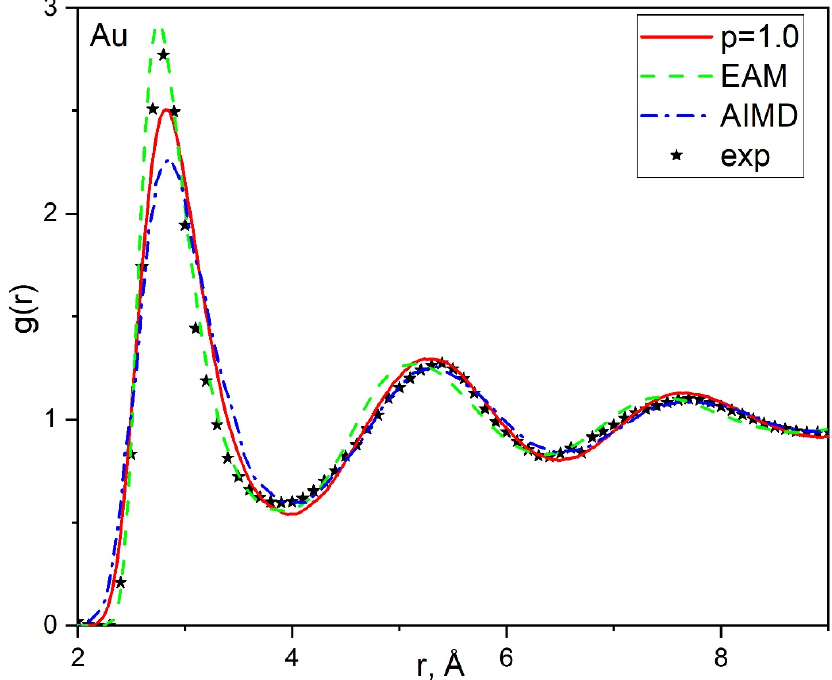
1 = p in comparison with ex-